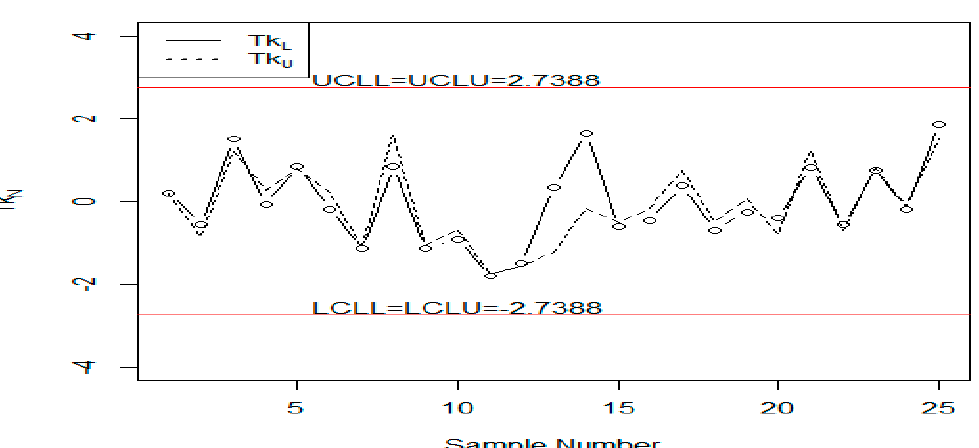
Figure 5. The existing chart proposed by Reference [38] for real data.